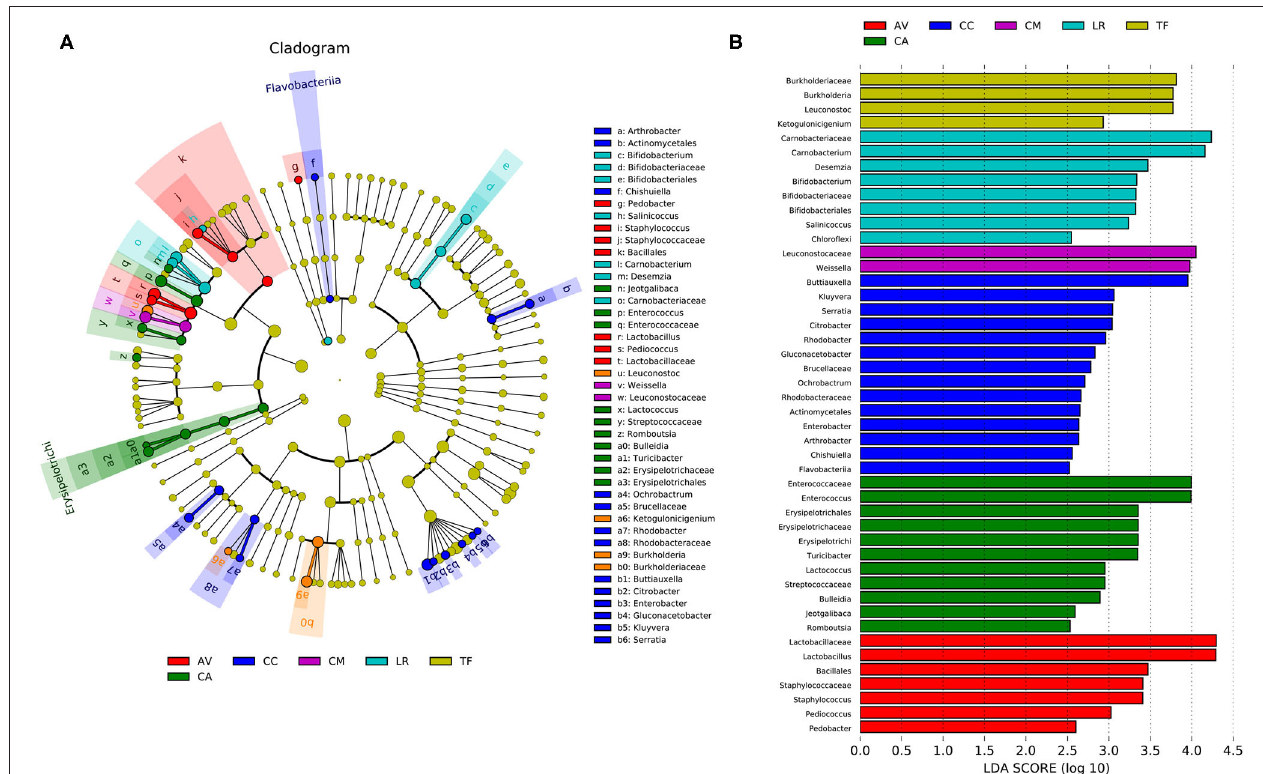
FIGURE 6 | Linear discriminant analysis effect size (LEfSe) analysis. (A) The cladogram diagram shows the microbial species with significant differences in the six species of birds. Different colors indicate different groups, with the species classification at the level of phylum, class, order, family, and genus shown from the inside to the outside. (B) Plot from LEfSe analysis. The plot was generated using the online LEfSe project. The length of the bar column represents the linear discriminant analysis (LDA) score. The figure shows the microbial taxa with significant differences between the six species of birds (LDA score > 2.0). AV, demoiselle crane ( Anthropoides virgo ); CA, black swan ( Cygnus atratus ); CC, whooper Swan ( Cygnus cygnus ); CM, muscovy duck ( Cairina moschata ); LR, relict gull ( Larus relictus ); TF, ruddy shelduck ( Tadorna ferruginea